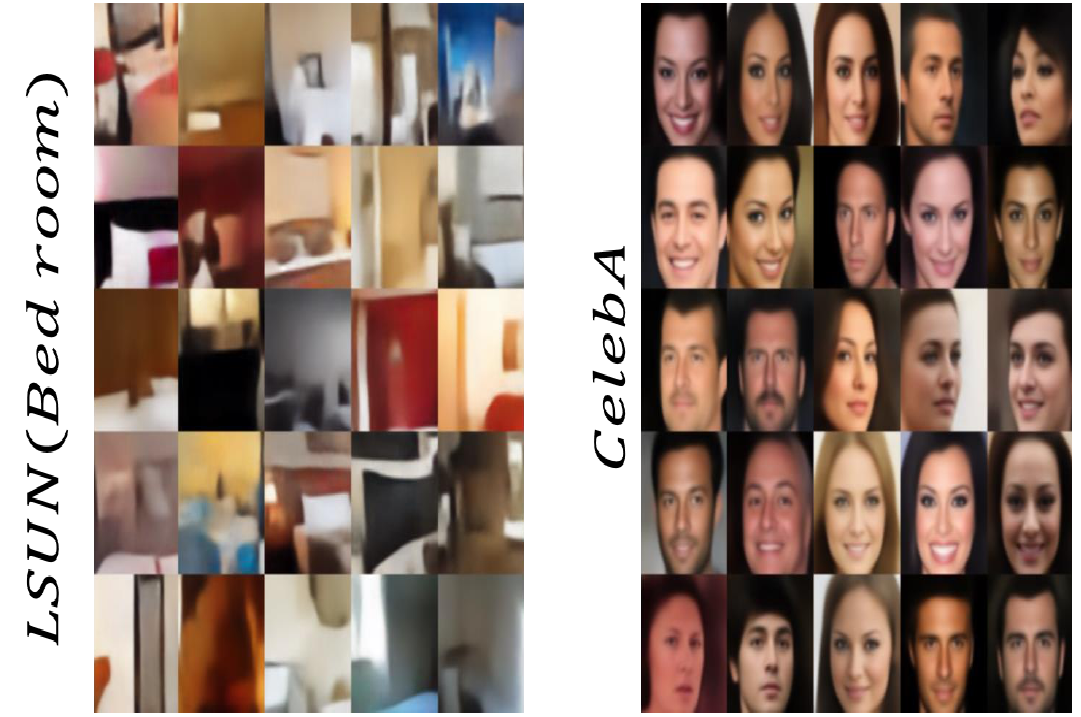
Figure A3. I mage generation result of LSUN bedroom and CelebA datasets at 200 epoch. Figure A3. Image generation result of LSUN bedroom and CelebA datasets at 200